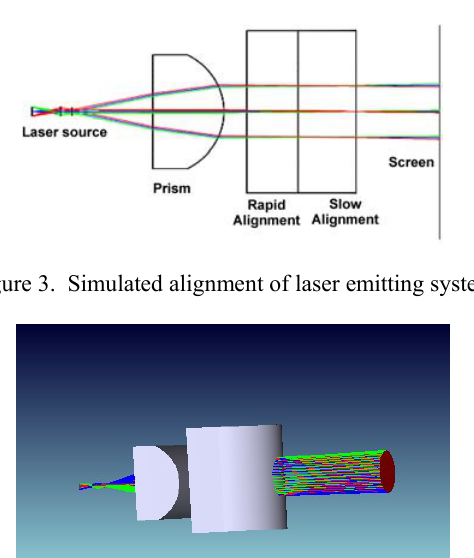
Figure 2. The illustration of divergence angle of laser emitting (Hu, 2005)